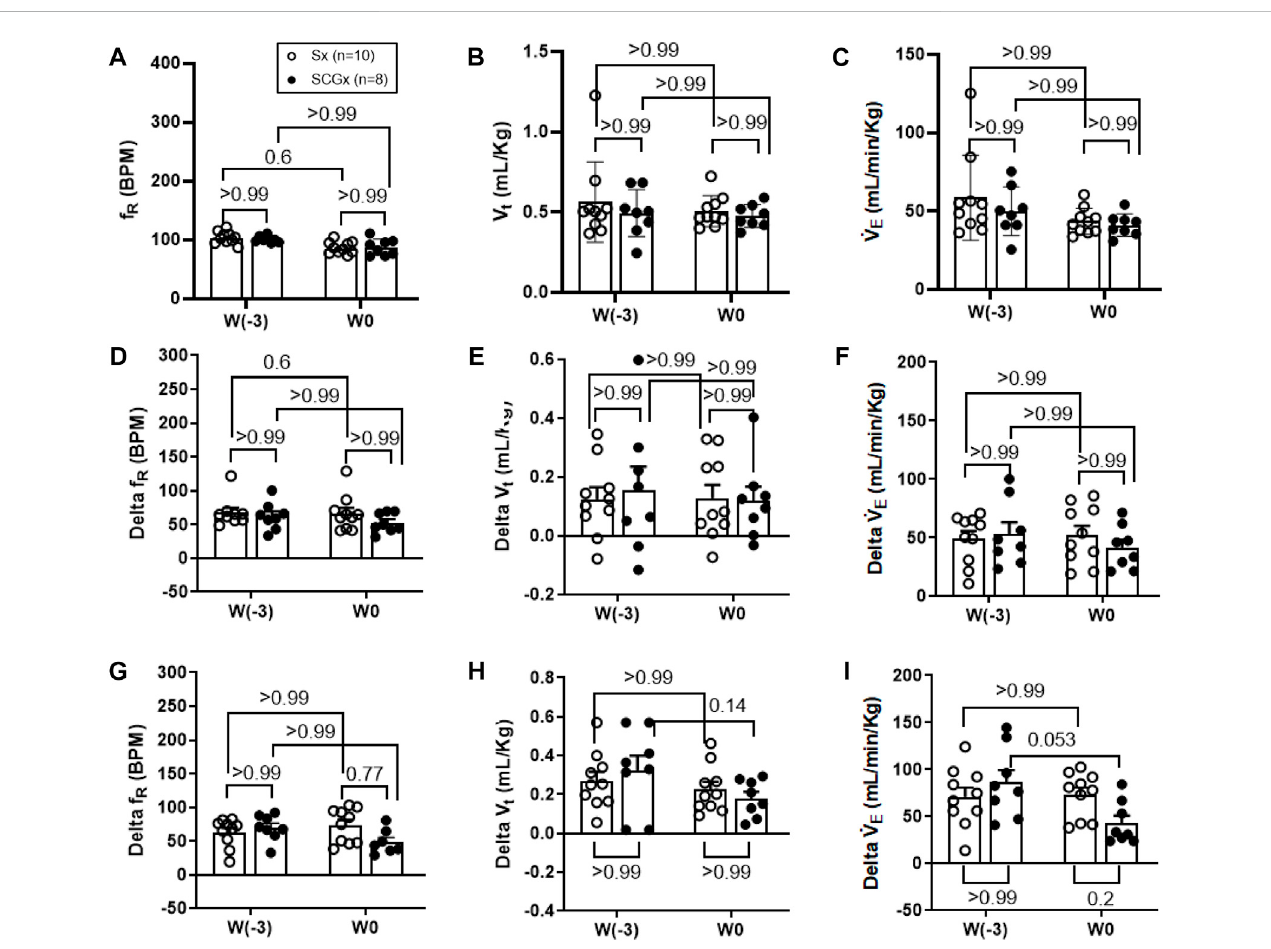
FIGURE 3 EffectofSx(n=10)andSCGx(n=8)onbothrestingventilatoryparameters (A – C) andchemore fl exactivationinresponsetoeither10%hypoxia (D – F) or to 5% normoxic-hypercapnia (G – I) in rats prior to bleo-treatment. Two-way ANOVA was applied using Bonferroni multiple comparisons, Values are mean ± SD; (A) Respiratoryrate(f R ); (B) Tidalvolume(V t ); (C) Minuteventilation(V _ E ). (D – F) changesinventilatoryparametersincludingf R, V t andV` _ E inresponseto10% hypoxia in rats prior to bleo-treatment. (G – I) changes in ventilatory parameters including f R, V t and V _ E in response to 5% normoxic-hypercapnia in rats prior to